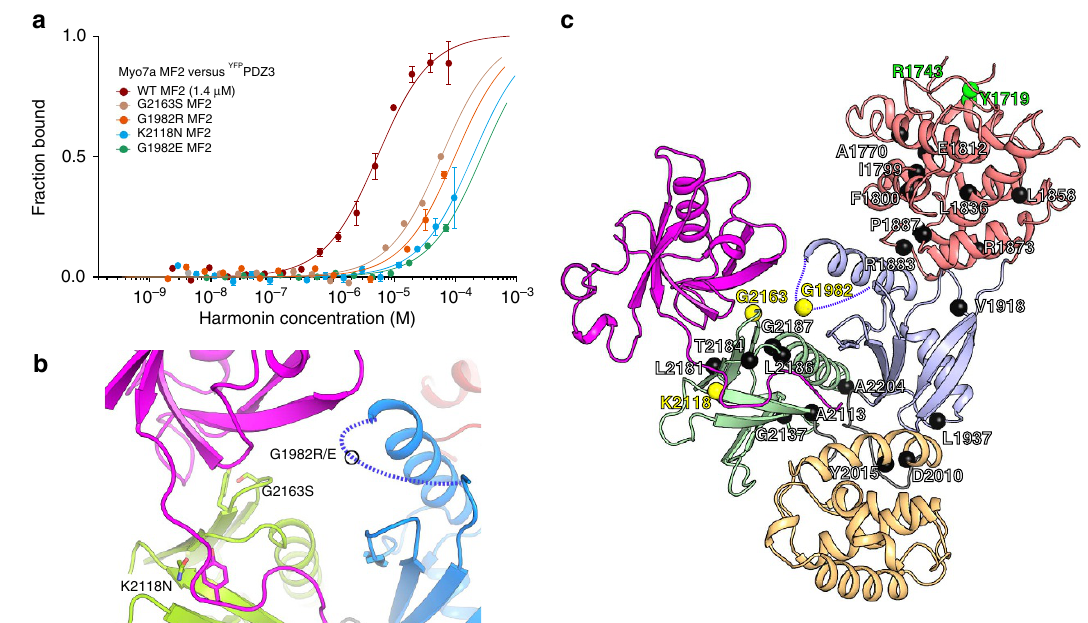
Figure 4 | Myo7a deafness mutations impair PDZ3c-MF2 interaction. ( a ) Analysis of the interactions between Myo7a MF2 deafness mutants and PDZ3c by MST. Averaged K d s from two technical replicates (mean ± s.d.) are shown. All four mutants display weak binding affinities ( 4 60 m M) ( b ) The location of the three surface mutations on the F1 (blue) and F3 (green) lobes of MF2 relative to PDZ3c (magenta) is shown. The missing loop in the F1 lobe is indicated by a dashed line. ( c ) The location of known deafness mutations found in Myo7a MF2 is shown in black spheres, with the mutants tested shown in yellow spheres (see also Supplementary Table 2 and Supplementary Movie 2).